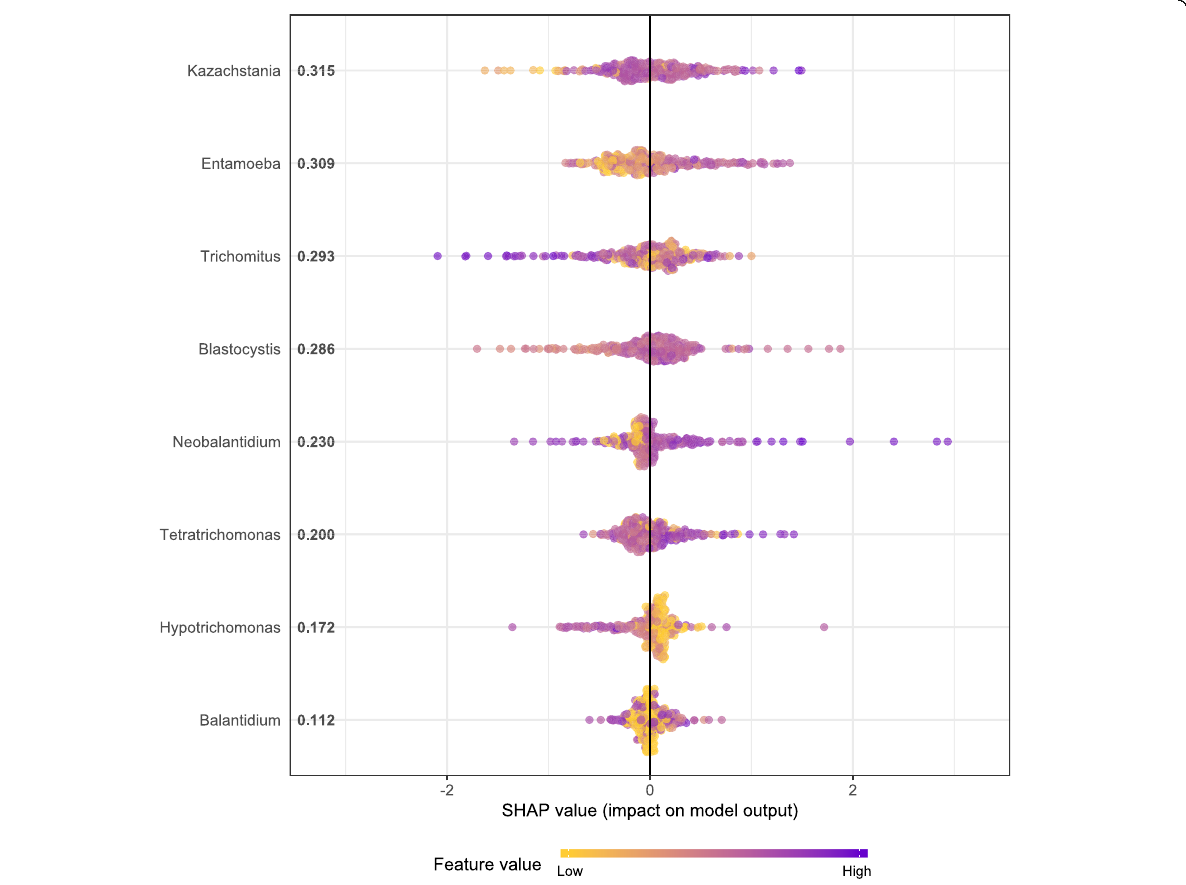
Fig. 3 Relevance of fungal and protist genera regarding piglets body weight, according to the Shapley Additive Explanation (SHAP) values. The x- axis represents the SHAP value, the y-axis shows the genera names in order of importance from top to bottom, and the value correspond to the genera mean SHAP